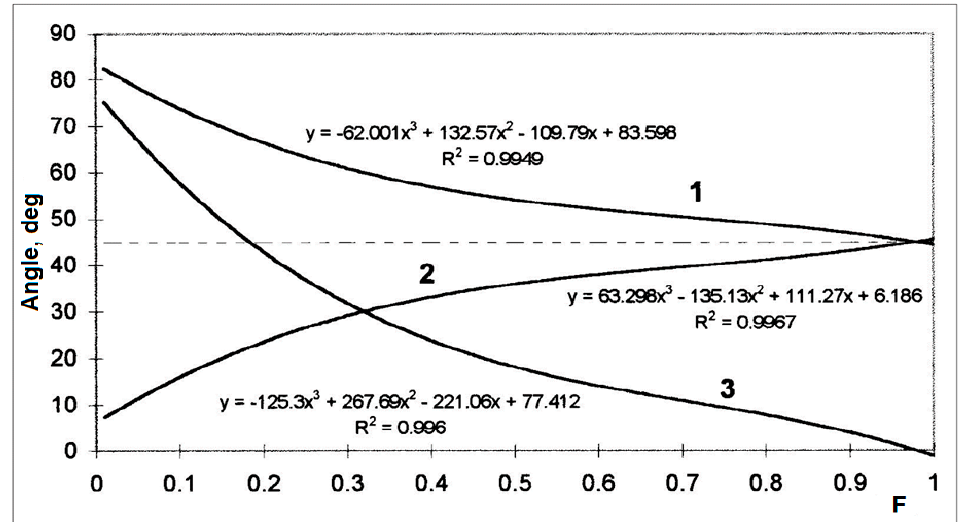
Figure 4. Nomogram for determining the maximum values of the angular parameters of the mechanical model from the friction anisotropy factor k / K.